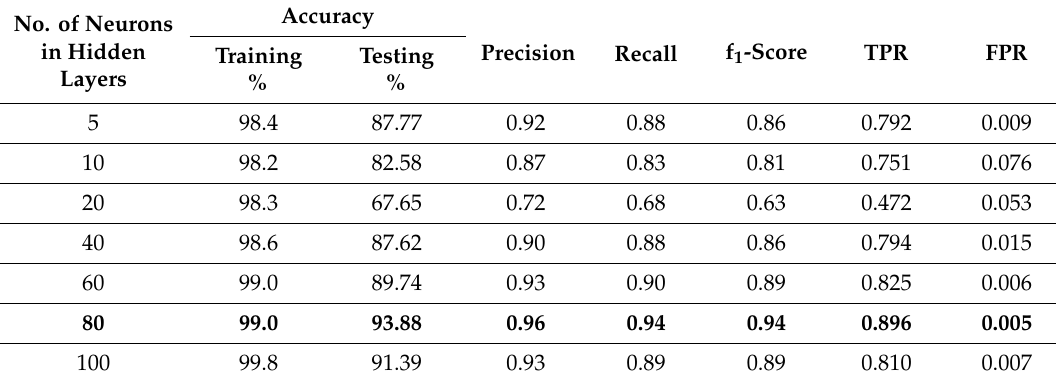
Table 9. Multi-class classification performance results using 99 features.